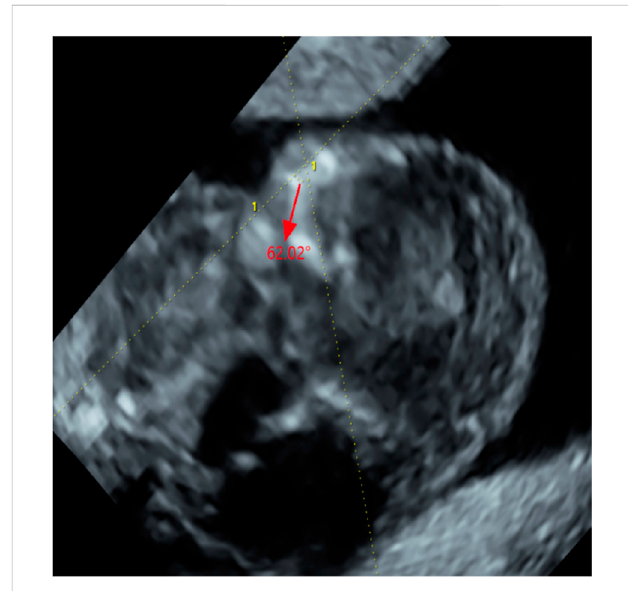
FIGURE 2 The measurement of Maxilla-nasion-mandible angle (MMF, 62.02 ° ) (red